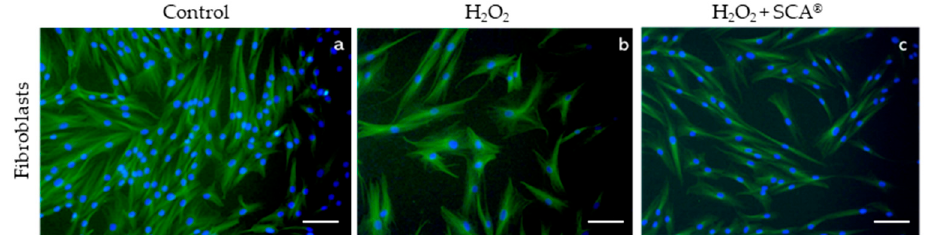
Figure 3. SCA ® treatment reversed morphological changes associated with senescence. Representative tubulin cytoskeleton images of control fibroblasts ( a ), fibroblasts treated with H 2 O 2 ( b ), and fibroblasts treated with H 2 O 2 + SCA ( c ). Representative inverted fluorescence microscopy images immunostained with anti-a-tubulin antibody appear in green, while nuclei that were stained with Hoechst probe appear in blue. Scale bars: 200 µm.